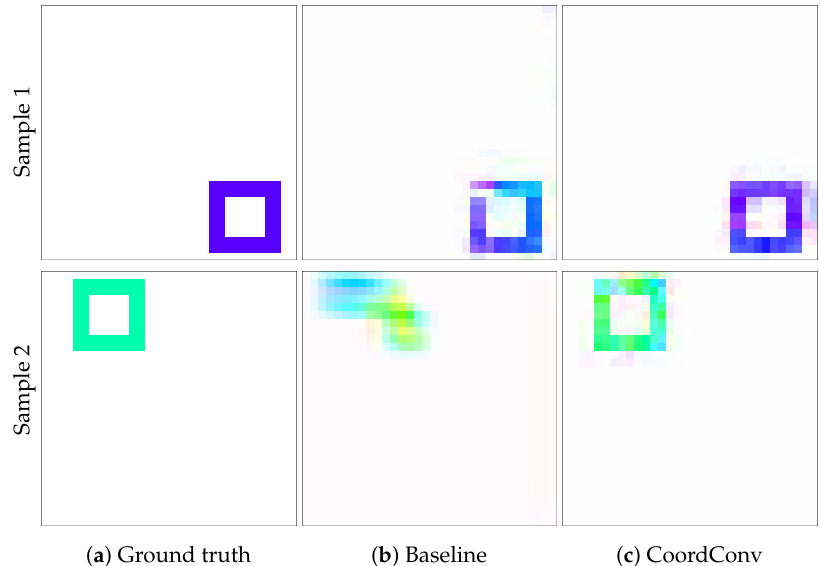
Figure 11. Validation samples after convergence on our toy dataset. Each row depicts a different sample and columns correspond to ( a ): ground truth optical flow, ( b ): baseline network prediction, and ( c ): CoordConv network